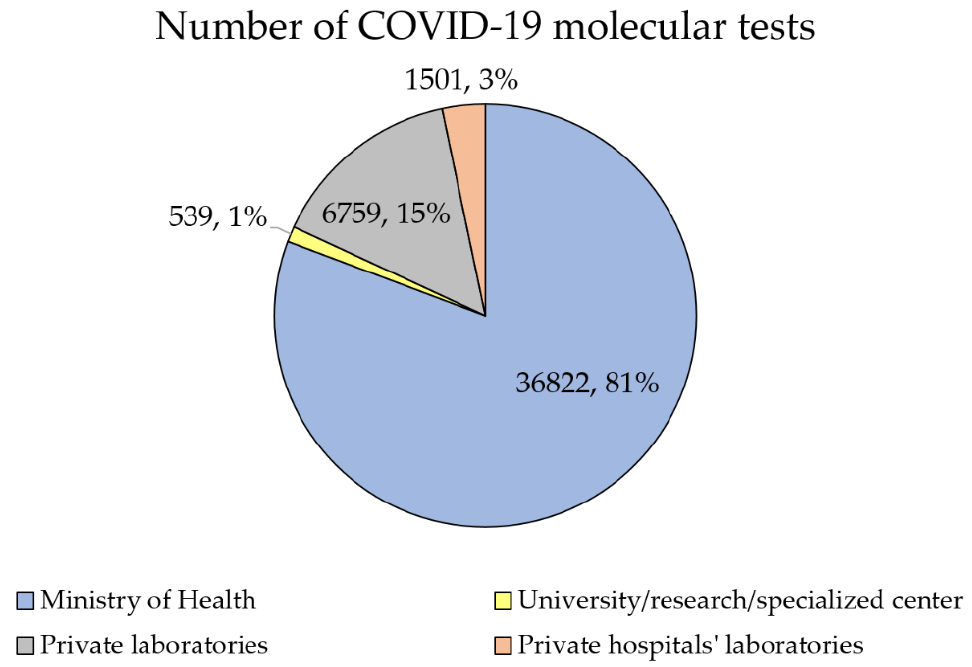
Figure 2. Total percentage of COVID-19 tests conducted by 11 April 2021, divided by health sector. Based on the daily average of COVID-19 molecular tests performed on the first week of April 2021, the same pattern was seen with MoH laboratories contributing to 80.7% of all tests ( n = 36,822), followed by private laboratories ( n = 6759, 14.8%). About three-quarters of these tests were conducted in the Central region ( n = 34,338, 75.3%), followed by the Northern region ( n = 7616, 16.7%) and the Southern region ( n = 3667, 8.0%).